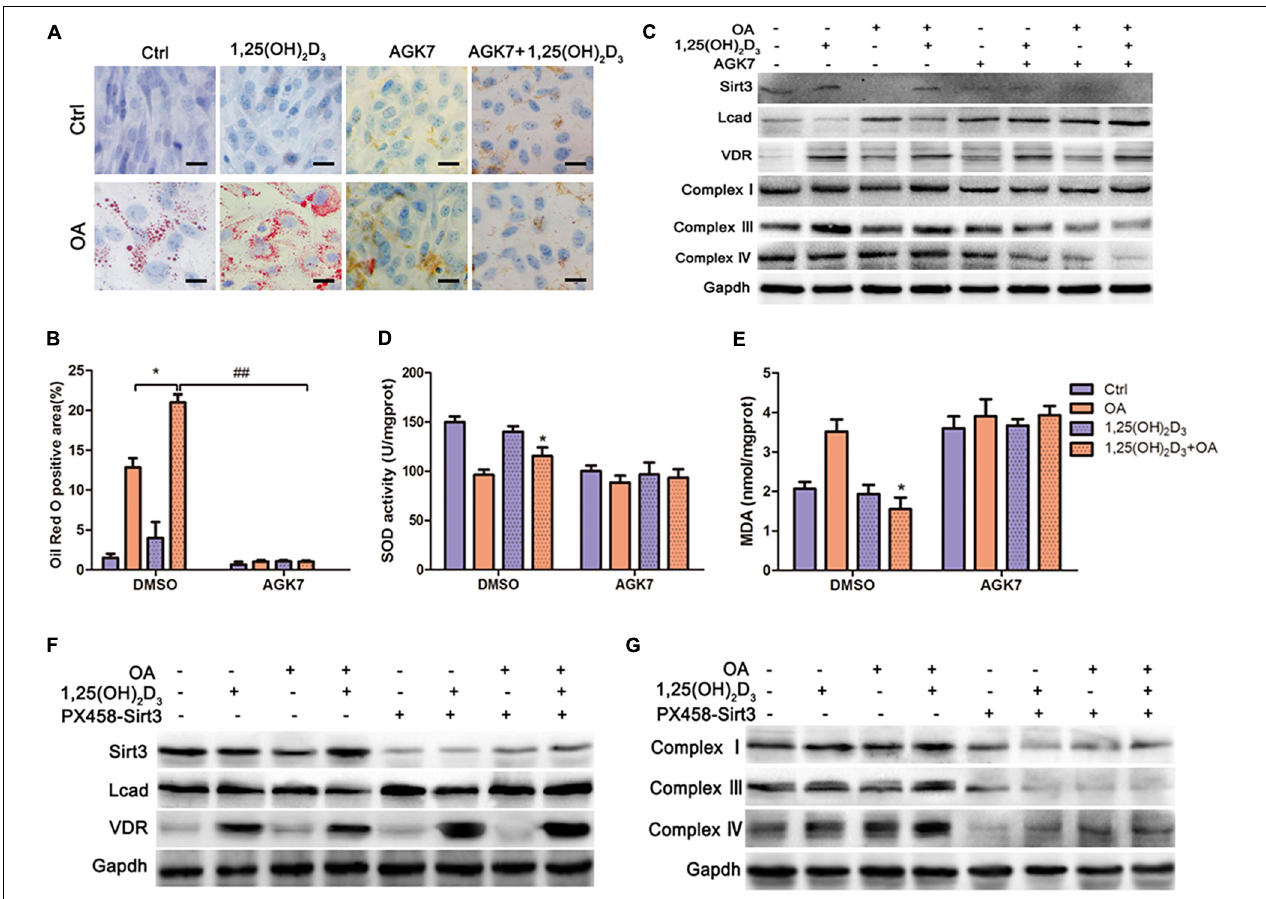
FIGURE 5 | VD/VDR regulated lipid metabolism and mitochondrial respiratory metabolism via SIRT3 to protect HL-1 cells against oxidative damage. (A,B) representative Oil Red O staining in cells treated with 1,25(OH) 2 D 3 , oleic acid (OA), and AGK7 (SIRT3 inhibitor) (original magnification: 400 × ). * p < 0.05, ## p < 0.01. (C) Protein levels of SIRT3, LCAD, VDR, complexes I, III, and IV in HL-1 cells treated with 1,25(OH) 2 D 3 , OA, and AGK7 were analyzed via western blot. Analysis of (D) MDA and (E) SOD with relative changes shown for the 1,25(OH) 2 D 3 + OA group compared with the OA group (* p < 0.05 vs. OA). (F,G) Western blot analysis of SIRT3, LCAD, complexes I, III and IV in cells with and/or without 1,25(OH) 2 D 3 , knockout of Sirt3 via CRISPR/Cas9, and OA, indicated that VD/VDR did not regulate fatty acid metabolism in the absence SIRT3.OA, oleic acid. PX458-Sirt3, knockout of Sirt3 via CRISPR/Cas9. AGK7, SIRT3